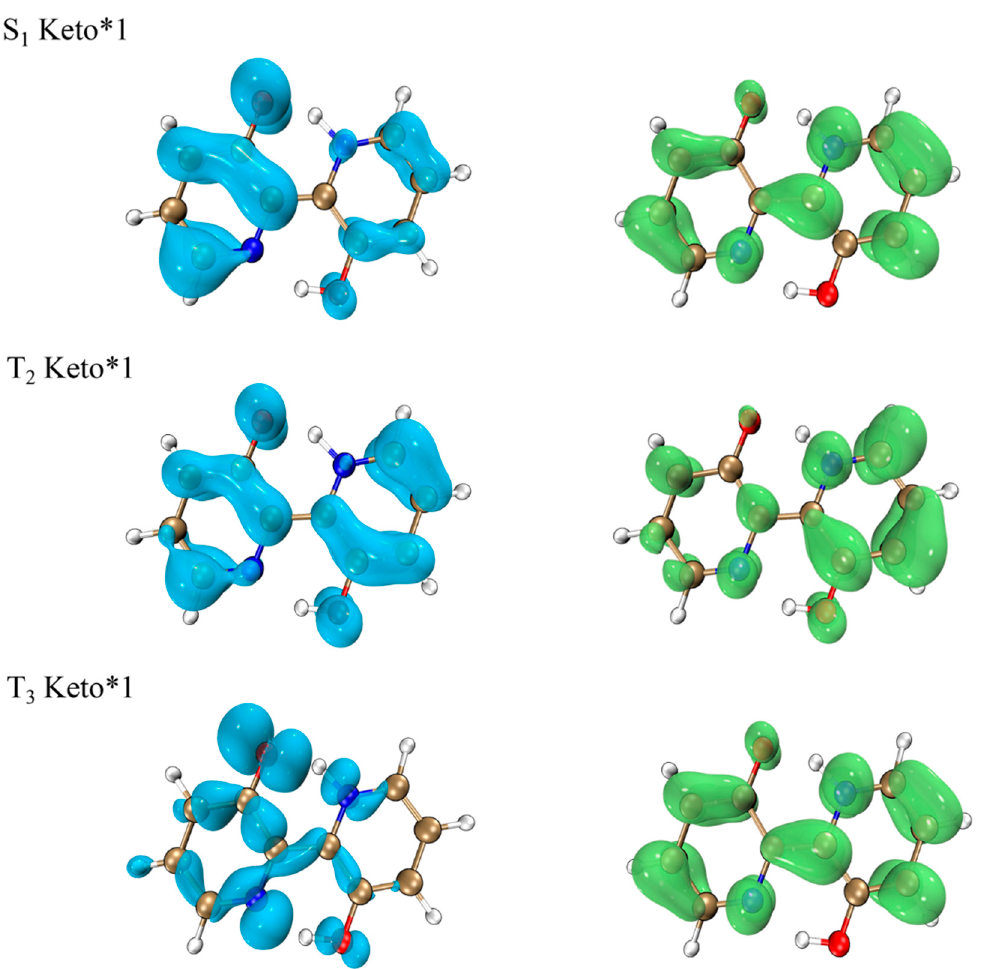
Figure 7. Electron-hole distribution based on the Keto*1 form in the excited states for BP(OH) 2 . Blue color and green color represent holes and electrons, respectively. The golden atom represents C, the blue atom represents N, the red atom represents O, and light grey atom represents H.